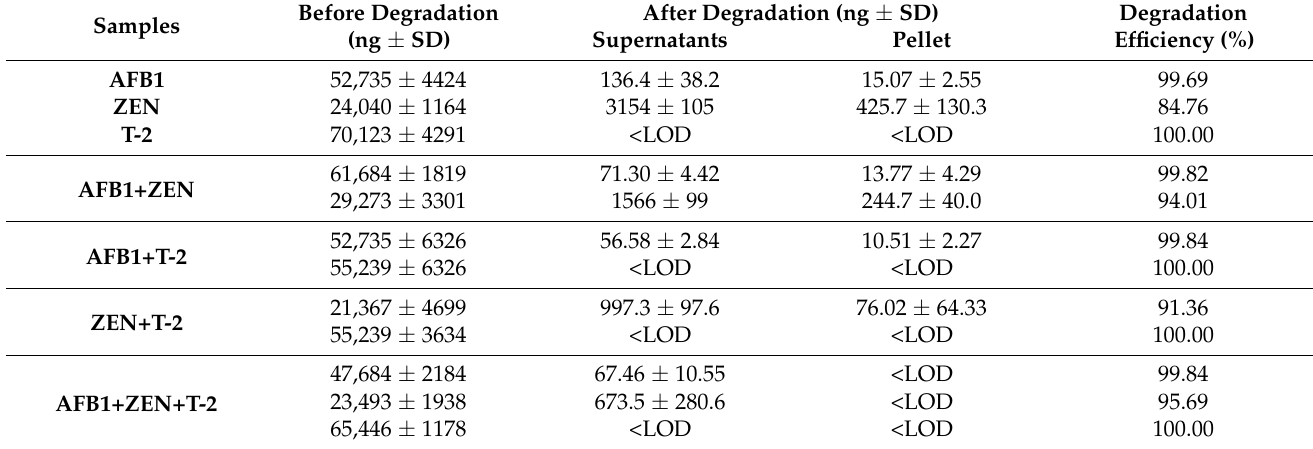
Table 1. Mycotoxins and their mixture degradation efficiency of the Rhodococcus erythropolis NI1 strain. The mycotoxin concentration of samples was detected by UHPLC-MS/MS. The supernatants and pellets of each mycotoxin and mixture were evaluated separately. The measured values of mycotoxin mixtures are listed in order of the sample labelling. Results of under detection limit are expressed as <